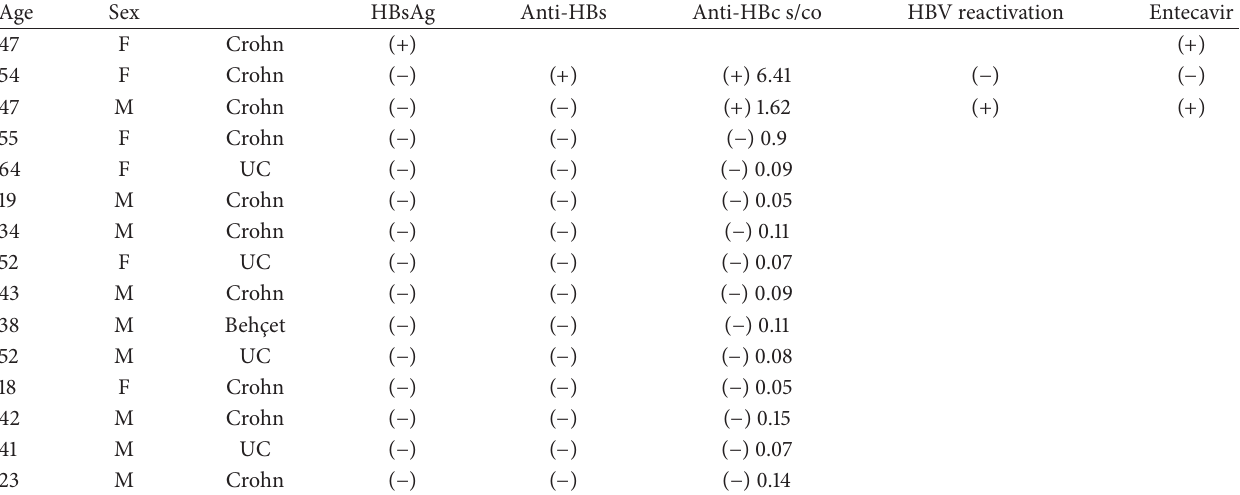
Figure 2: Clinical course. HBV-DNA and ALT levels were screened every month after the start of infliximab. Table 2: HBV markers in patients treated with